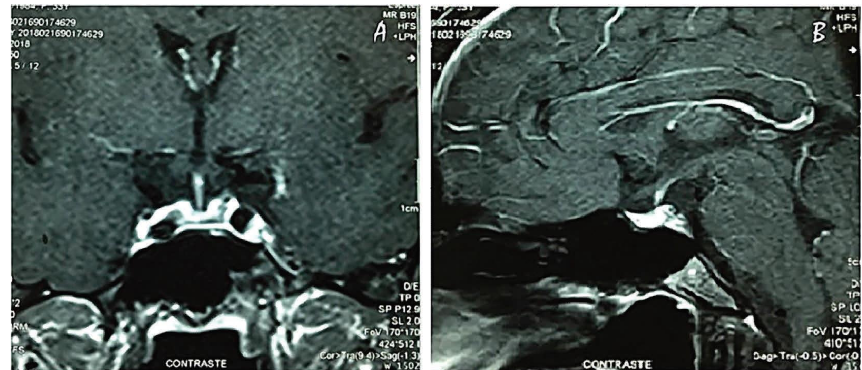
Figure 2: Coronal (a) and sagittal (b) postcontrast MRI 7 months after diagnosis showed a smaller pituitary gland with peripheral enhancement after gadolinium